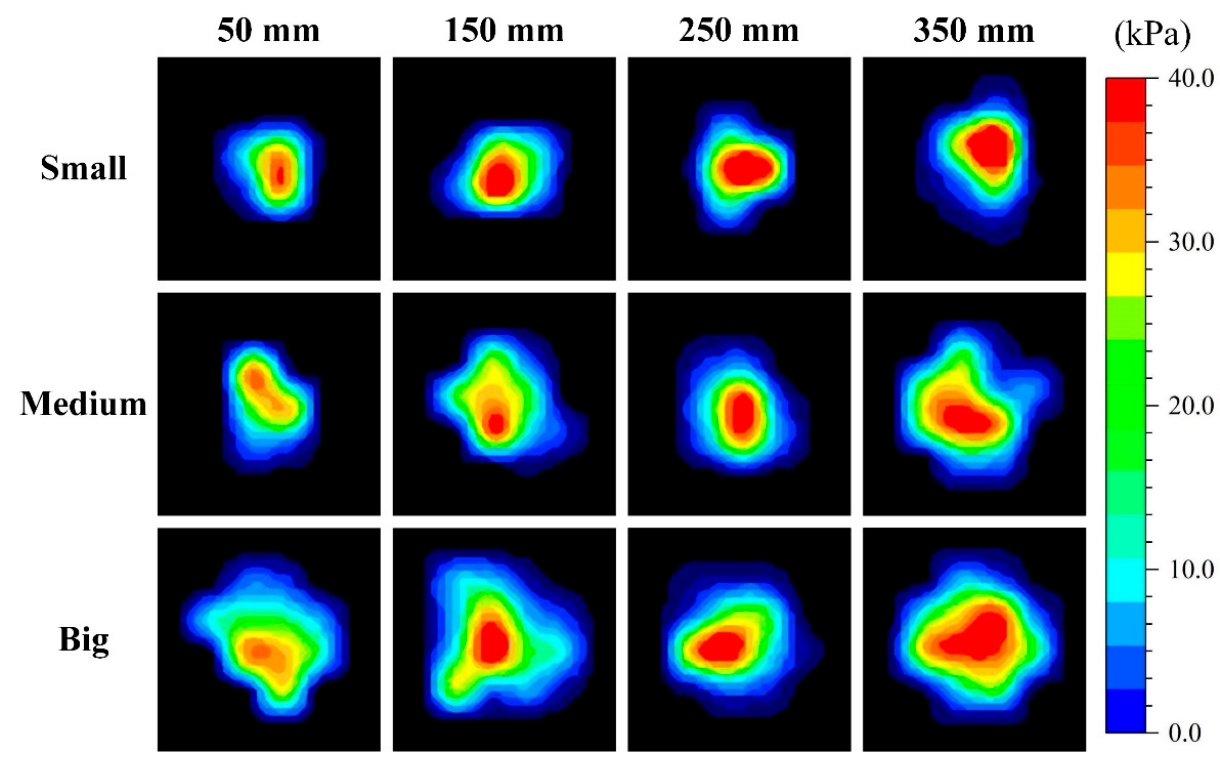
Figure 10. Pressure distribution contours at different drop heights for three seedling pot sizes.